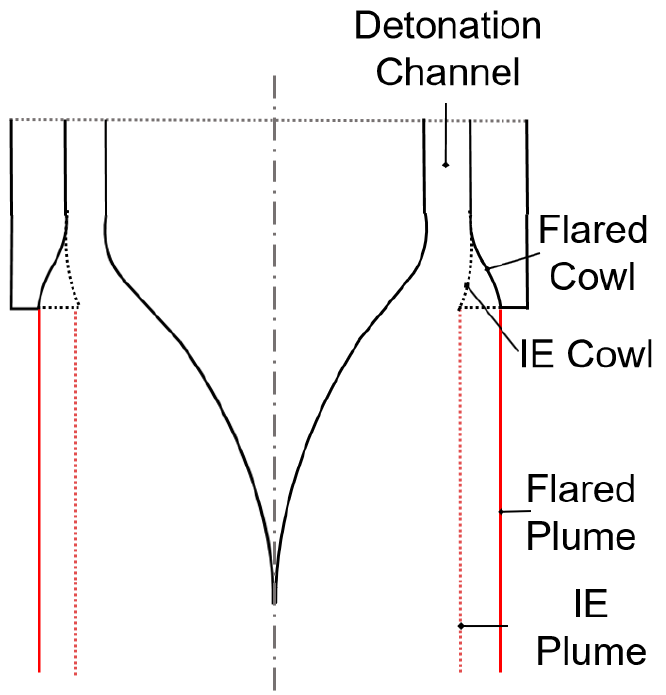
Figure 3. Internal expansion (IE) and Flared nozzle topologies that may be employed in RDRE. The flared configuration would be preferred for large expansion area ratio space engine applications and is the focus of the present study.